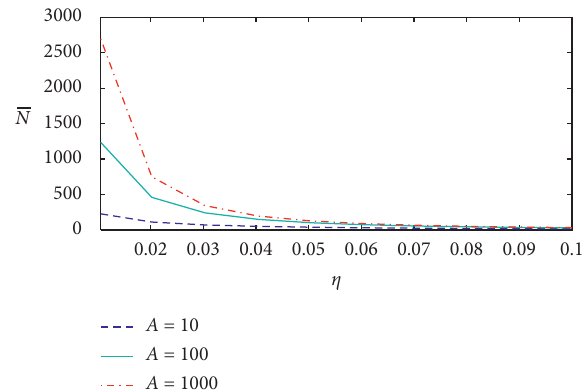
Figure 10: Plots of the mean number of photon pairs (equation (35)) versus η for κ � 0 . 8, ε � 0 . 399, n th � 0 . 15 and for different values of linear gain coefficients.